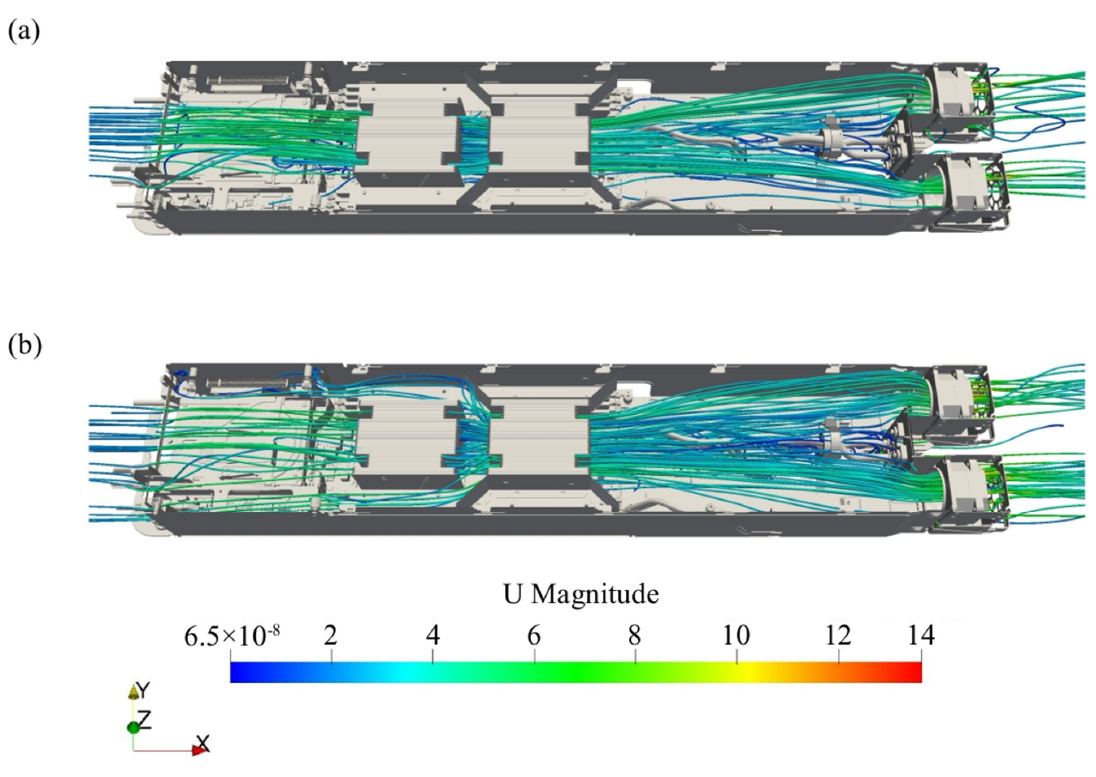
Figure 10. Three ‐ dimensional streamlines through ( a ) front and ( b ) rear heat sinks. Figure 10. Three-dimensional streamlines through ( a ) front and ( b ) rear heat sinks.